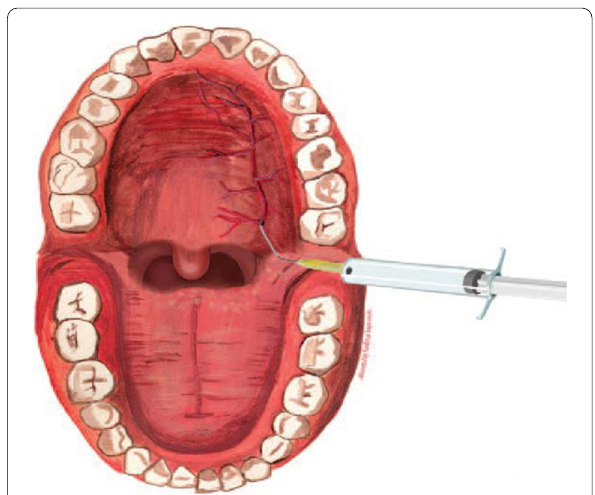
Fig. 1 Pterygopalatine fossa injection trans‑oral